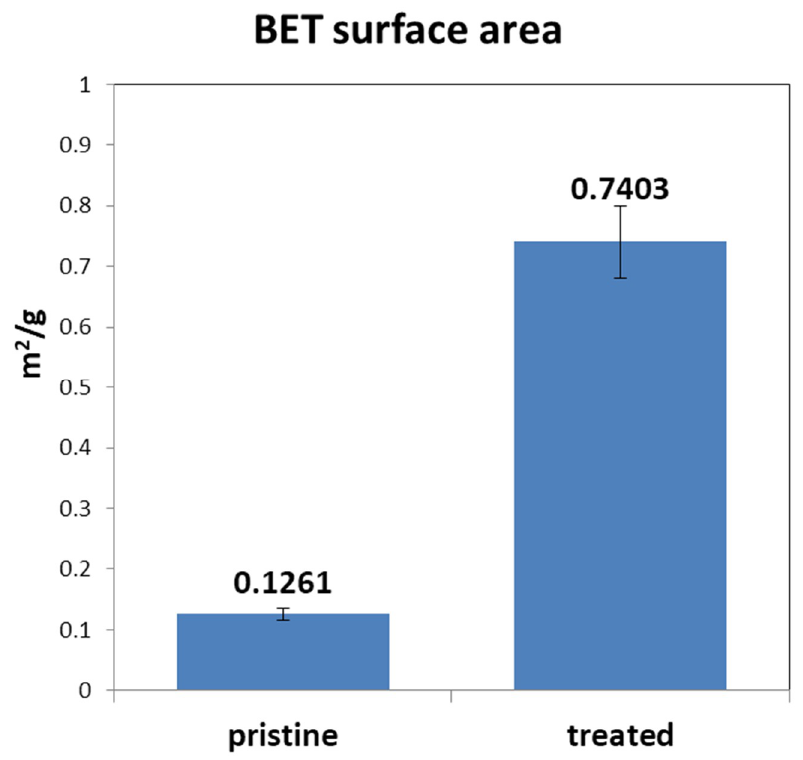
Figure 5. The diagram of the Brunauer–Emmett–Teller (BET) surface area results of the pristine and the atmospheric plasma treated felt.